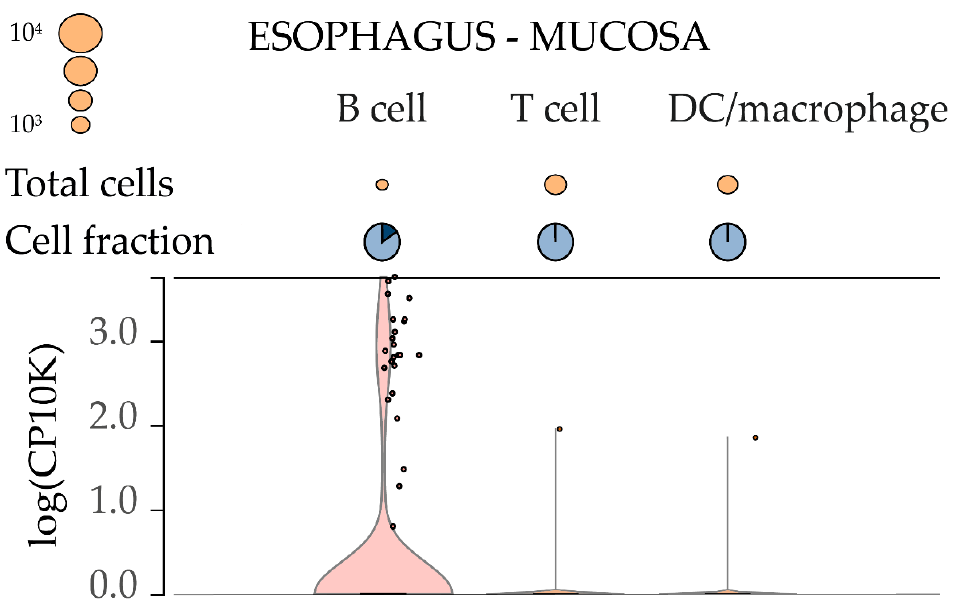
Figure 2. Analysis of AL928768.3 expression using available single-nucleus RNA sequencing data. In cell types other than B-lymphocytes, AL928768.3 expression was detected only in a few individ- ual cells.